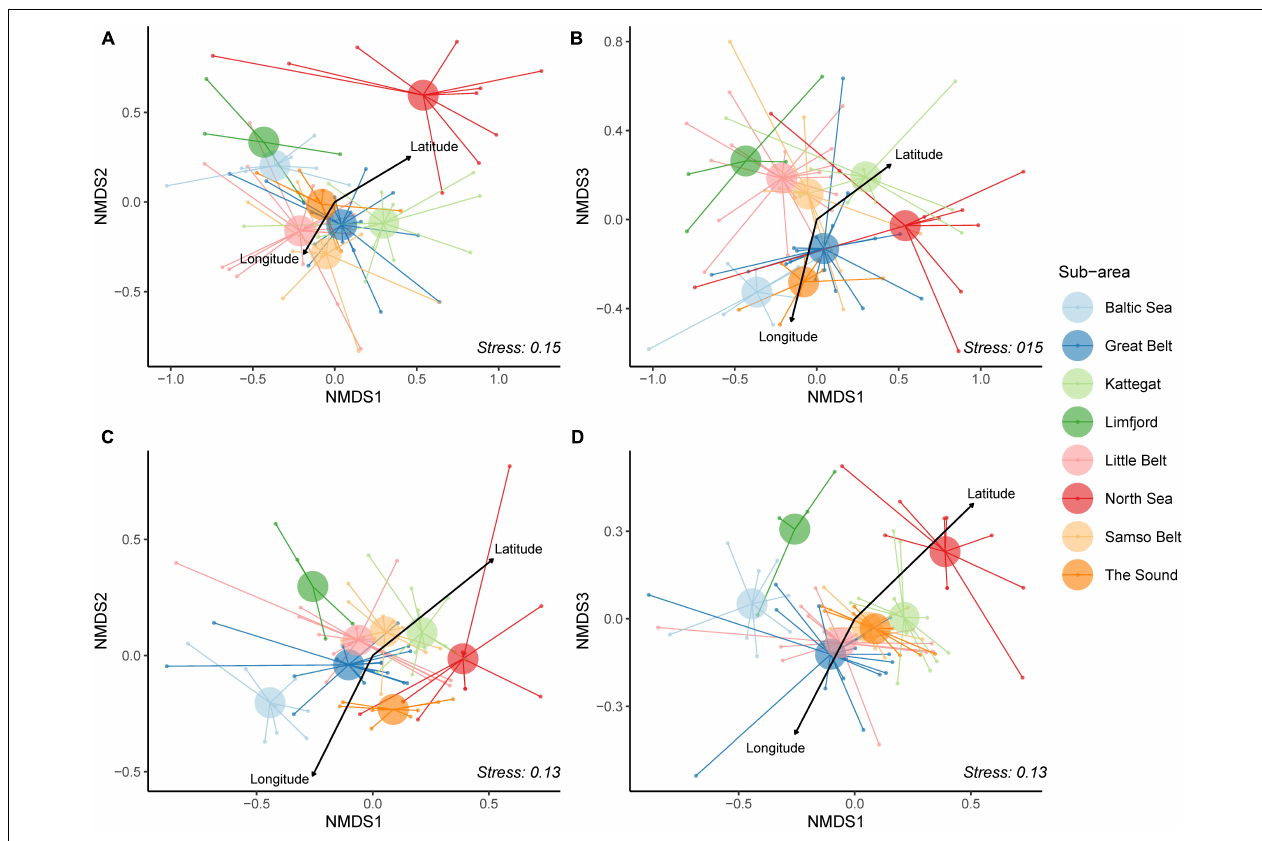
FIGURE 5 | Non-metric multidimensional scaling (NMDS) on three dimensions were used on the presence-absence data for both datasets. (A) eDNA dataset on axis one and two. (B) eDNA dataset on axis one and three. (C) Fish Atlas dataset on axis one and two. (D) Fish Atlas dataset on axis one and three. The centroid of the sub-areas is enlarged and colored according to sub-areas: North Sea (red), Limfjord (dark green), Kattegat (light green), Samso Belt (light orange), Great Belt (dark blue), Little Belt (pink), Baltic Sea (light blue) and The Sound (dark orange). The Latitude and Longitude are showed, with the arrow length corresponding to their relative